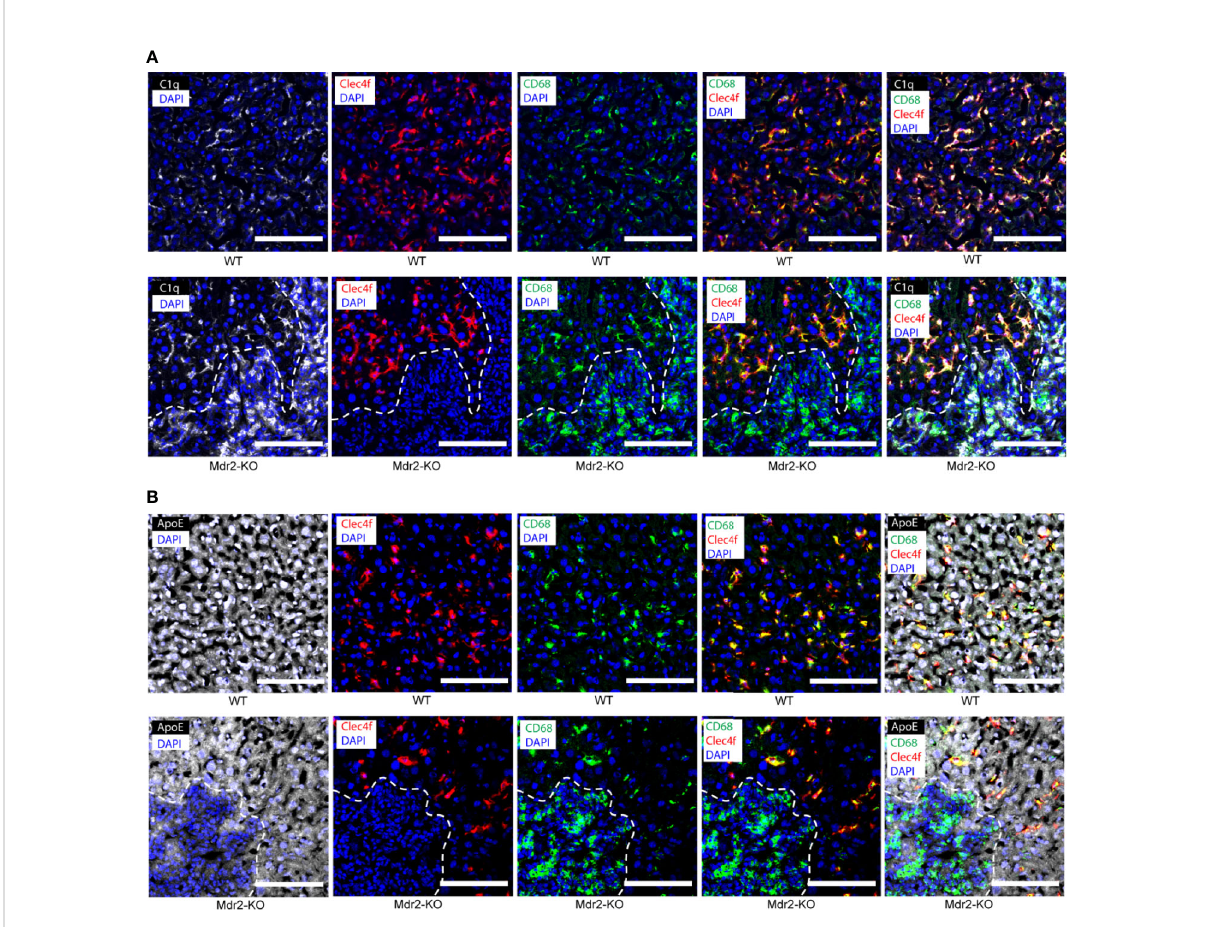
FIGURE 2 C1q- and ApoE-expressing cells in 3 month old WT and Mdr2-KO mouse livers. (A) Liver sections were stained with C1q (white), Clec4f (red) for KCs, CD68 (green) for macrophages and DAPI (blue) for nuclei. Dotted lines demarcate immune cell in fi ltrates in the portal tract areas from surrounding liver tissue. KCs are known to stain CD68 + /Clec4f + . (B) Liver sections were stained with ApoE (white), Clec4f (red) for KCs, CD68 (green) for macrophages and DAPI (blue) for nuclei. Dotted lines demarcate immune cell in fi ltrates in the portal tract areas from surrounding liver tissue. Representative images of WT livers (n=6); Mdr2-KO livers (n=6) are shown. Scale bars 100 m